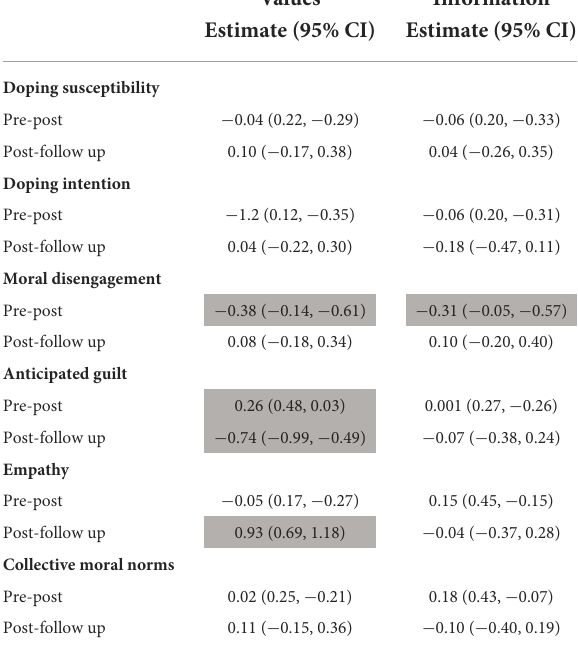
TABLE 4 Adjusted pre-post and post-follow up changes by intervention groups.